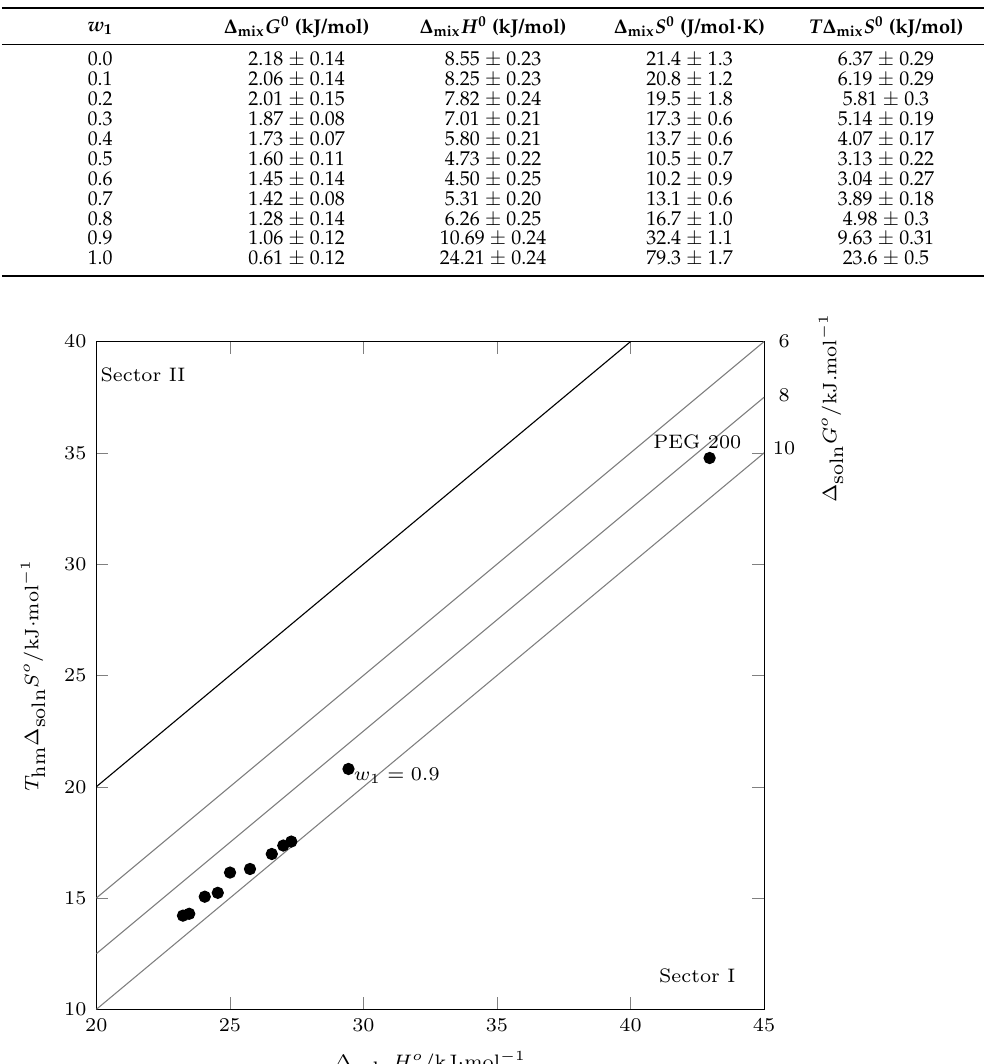
Table 7. Thermodynamic functions of mixing isoniazid (3) in (PEG 200 (1) + water (2)) cosolvent mixtures at 297.6 K and a pressure p = 0.096 MPa.